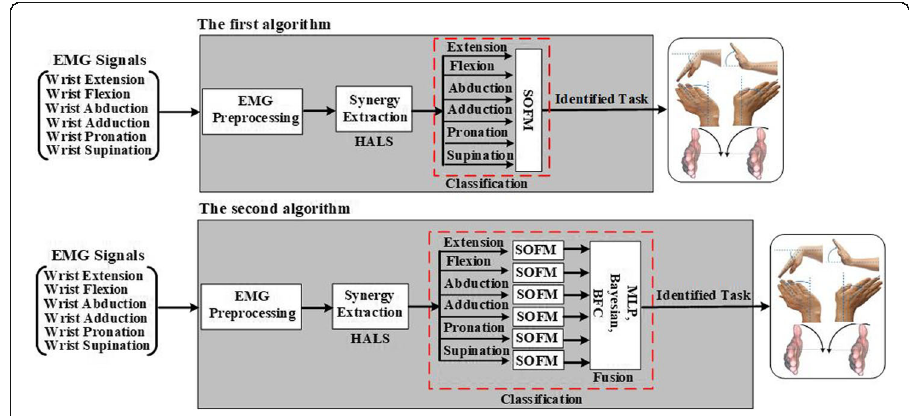
Fig. 2 Schematic of the proposed wrist movement detection strategies. In the first algorithm, no fusion algorithms were used and a single SOFM classifier was used. In the second algorithm, the fusion algorithms (MLP based, Bayesian based, BFC based) were used along with six SOFM